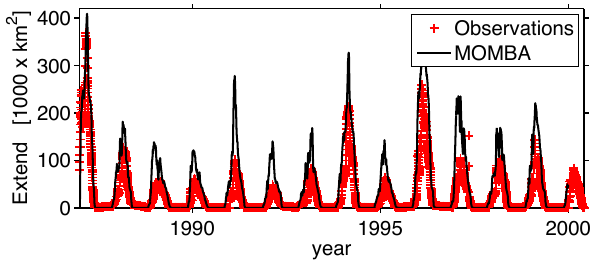
Fig. 17. Ice covered area in the Baltic Sea. The red line denotes an estimate based on digitised Figure 17. Ice-covered area in the Baltic Sea. The red line denotes ice-charts from the operational ice service provided by SMHI. The black line shows daily mean an estimate based on digitised ice charts from the operational ice simulated ice extent. service provided by SMHI. The black line shows daily mean simu- lated ice